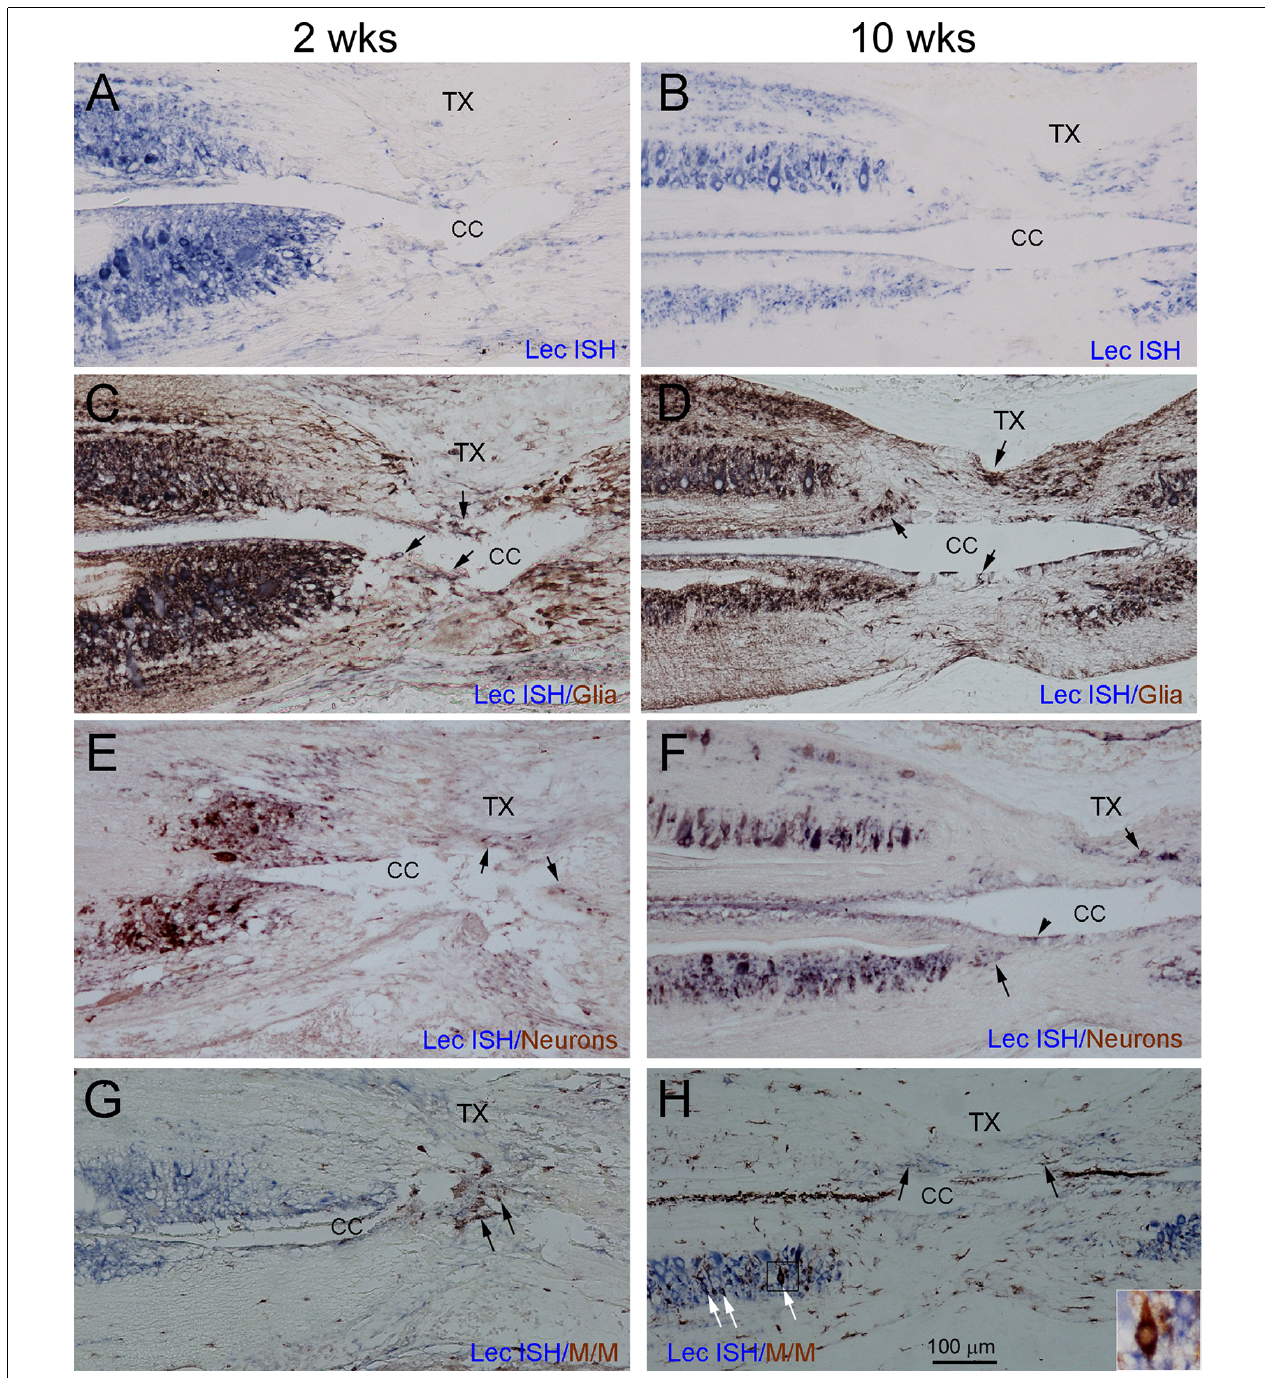
FIGURE 10 | Glia, neurons, and microglia/macrophages all contribute to the increase in CSPGs after SCI, and to scar formation. To characterize the cellular sources responsible for the increase in CSPGs after lamprey SCI, serial horizontal sections spanning the lesion site were collected from each lamprey at 2 (left column) and 10 weeks (right column) post-TX and processed by ISH (in blue) to detect lectican mRNAs, using probe 1. After ISH, IHC was performed (in brown) to identify glia (C,D) , neurons (E,F) , and microglia/macrophages (G,H) . (A,B) Sections labeled by ISH alone show expression of lectican mRNAs primarily in gray matter around the central canal, and to a more limited extent, in the lesion site. (C,D) The same sections shown in (A,B) are additionally stained for glia. Arrows point to doubly labeled glial cells in the lesion site. (E,F) The same sections show doubly labeled neurons in the lesion site (arrows). Arrowhead in (F) indicates CSF-contacting neurons (Zhang et al., 2014b). (G,H) The same sections show IB4-positive microglia/macrophage profiles in the lesion site; some are doubly labeled by lectican-ISH (black arrows). At 10 weeks (H) , the numbers of IB4-positive microglia/macrophage profiles are increased, and some neurons also are labeled by IB4 (white arrows). The inset in (H) is an enlarged image of the small box showing a neuron doubly labeled by ISH and IHC.